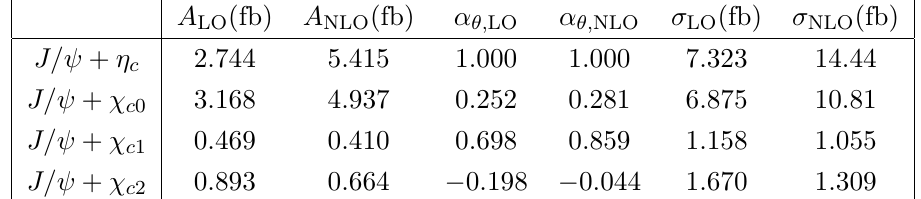
√ s = 10 . 6 GeV. A and α θ are the coefficients in